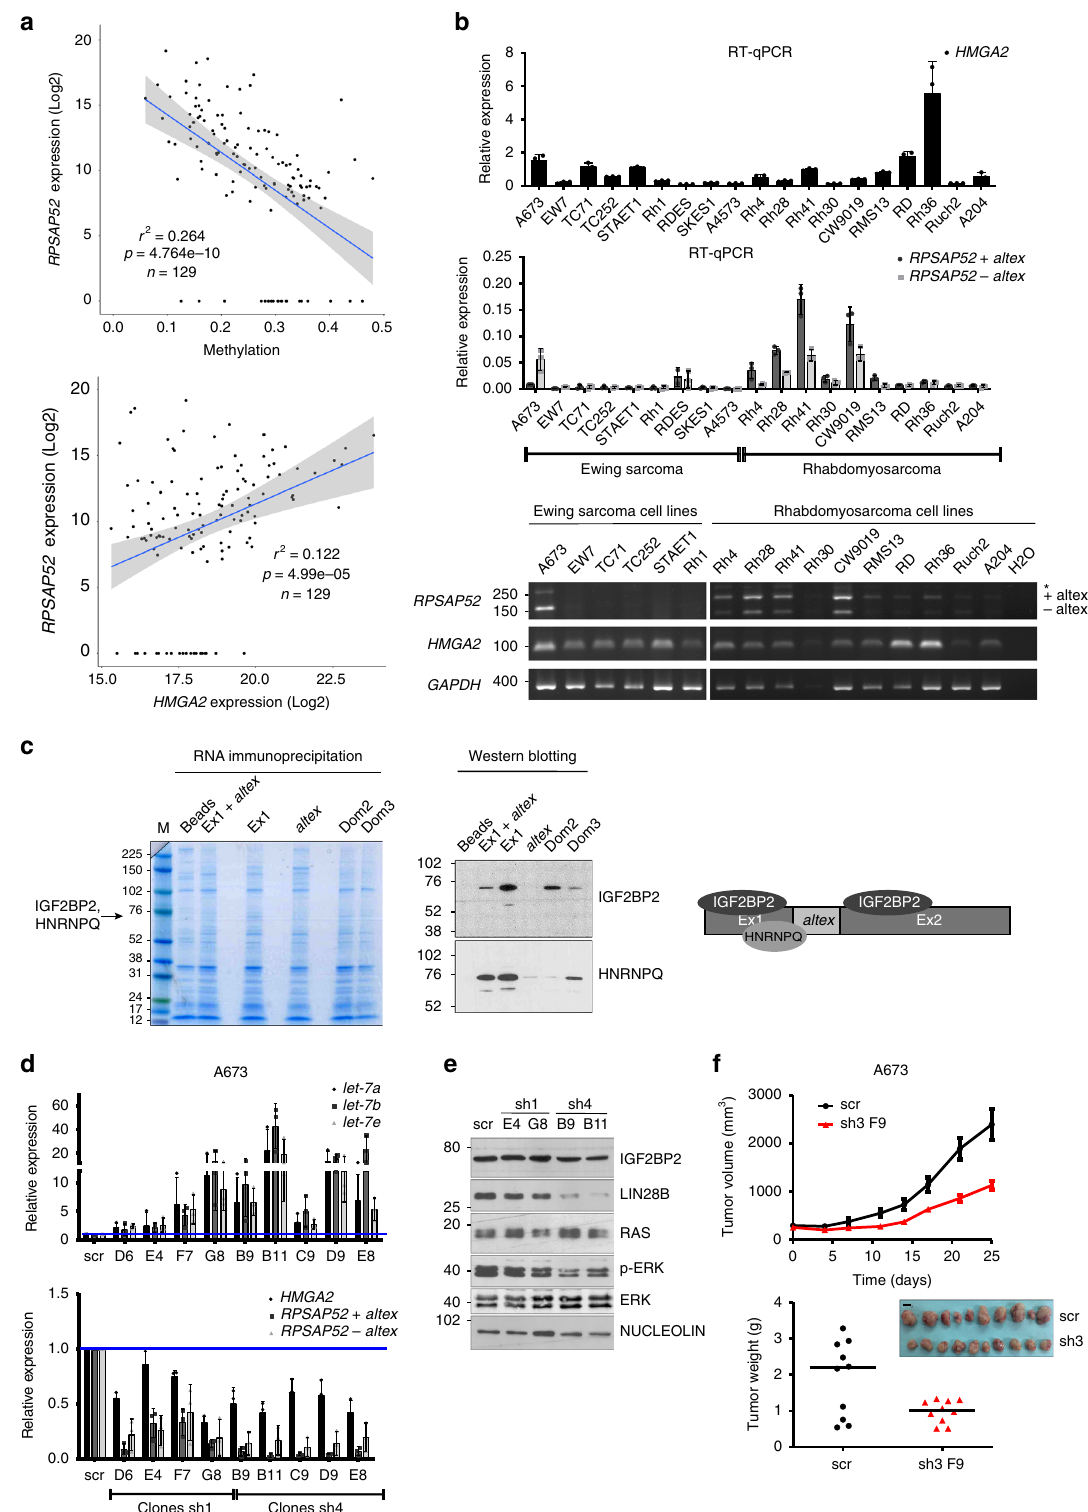
altered (Supplementary Fig. 5g), pointing to a decrease in their translation as a consequence of a diminished binding to IGF2BP2. RPSAP52 controls IGF2BP2 and mRNA distribution on polysomes . To obtain direct evidence of the changes in transla- tion ef fi ciency for speci fi c IGF2BP2 targets, we analyzed